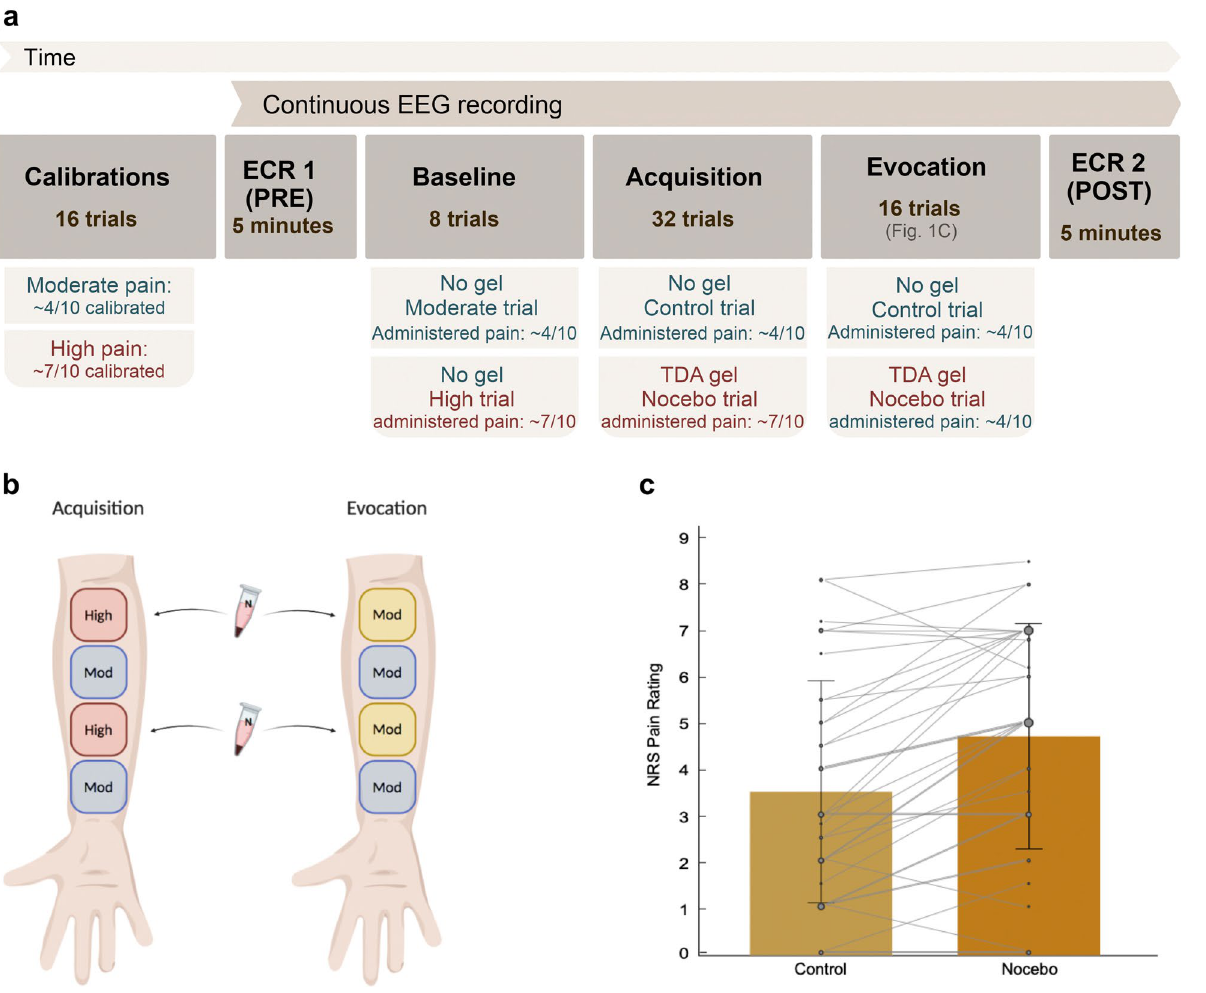
Figure 1. Experimental protocol and induced nocebo effect. ( a ) All participants underwent pain calibrations before continuous EEG measurements. At the start of the recording, participants completed a first (PRE) resting-state, received (baseline) moderate and high pain stimulations, and underwent nocebo acquisition via conditioning and verbal suggestions, nocebo evocation, and a second (POST) resting-state. Blue and red fonts indicate the lower and higher pain conditions, respectively. ECR Eyes-Closed Rest, PRE Pre-acquisition, POST Post-acquisition, TDA Trans-Dermal Aspartate (sham hyperalgesic gel). Approximate pain in ( a ) represents the moderate and high pain stimulations administered during acquisition and evocation, while ( c ) represents reported pain during the moderate pain stimulations of the evocation phase. ( b ) Application sites where either no gel or sham hyperalgesic gel was applied. Starting from the most distal patch on the right volar forearm, either no gel was applied on control sites or the sham hyperalgesic gel “TDA” was applied on the nocebo sites. During nocebo acquisition, moderate thermal pain was administered on control sites and high pain was administered on nocebo sites. During evocation, pain stimulations were administered at moderate intensity. ( c ) Manipulation-check results showing the pain ratings for the first nocebo and the first control trials of the evocation phase for all participants ( n = 36). Error bars depict standard lus was initiated from a 32 °C baseline, increased to a target temperature, and presented for 10 s at plateau. The ramp up and return rates were 8 °C per second. During calibrations the inter-stimulus interval (ISI) was 5 s, dur- ing which NRS pain ratings were given. Median temperatures rated as NRS 3 to 5 were used to induce moderate pain and median temperatures rated as NRS 6 to 8 were used to induce high pain. Baseline, acquisition, and evocation phases. During baseline, 2 moderate and 6 high pain trials were adminis- tered on both arms, with an ISI of 5 s. During acquisition, 16 nocebo and 16 control stimuli were administered in alternating order. During evocation, 8 nocebo and 8 control stimuli were administered in alternating order. During nocebo acquisition and evocation, the ISI was 10 s. In all phases the thermode was moved to a more proximal site on the arm after each pain trial, in order to avoid habituation or sensitization to heat-pain.